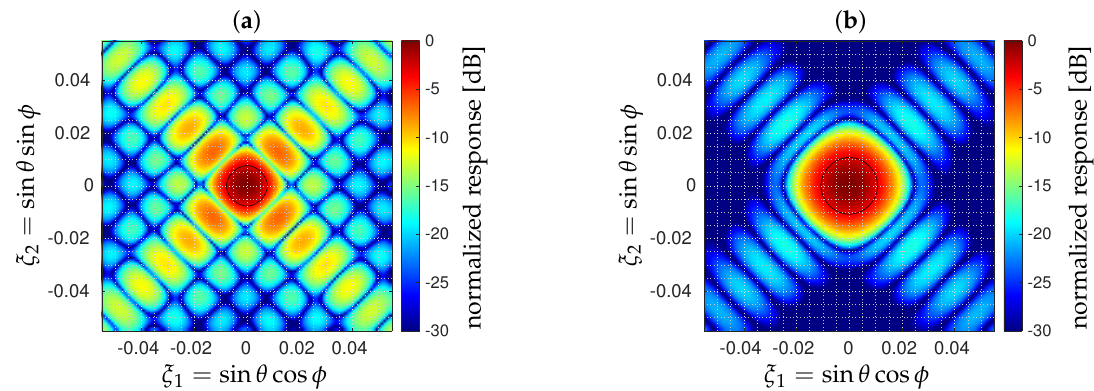
Figure 17. Closed views of the normalized synthetic responses of the cross-shaped array shown in Figure 4 when the shortest spacing d is set to 0.69 λ . The FWHM value of the main beam, here illustrated by the black circles, is about 0.43 ◦ ( a ) without an apodization window and about 0.61 ◦ ( b ) with a Blackman apodization window. Here, the reconstruction operator is (cid:101) G + ; identical responses are obtained with (cid:101) G + n when n = 16 additional singular values are discarded prior to the